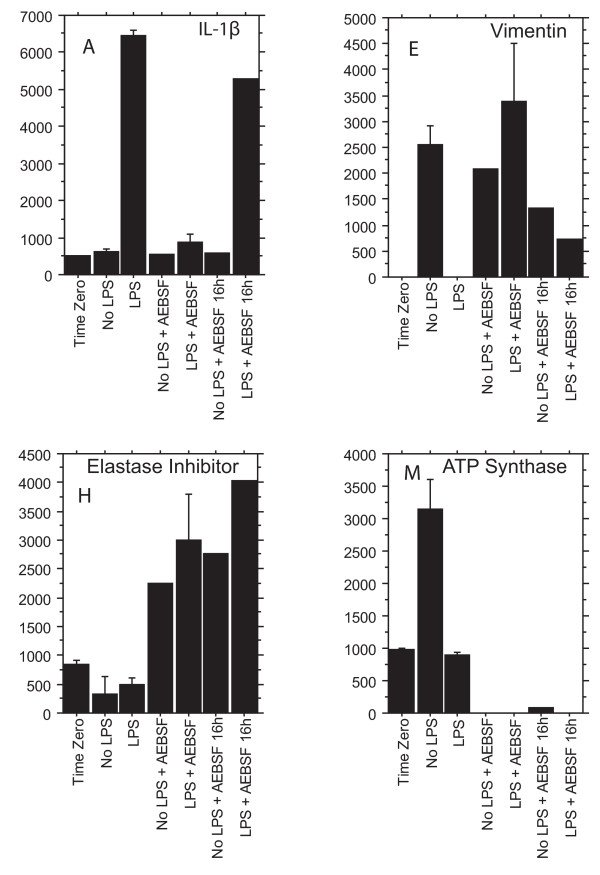
Effects of LPS and AEBSF on expression of IL-1β, elastase inhibitor, vimentin, and ATP synthase. Protein levels from 2D gels from monocytes cultured for 16 h ± LPS ± AEBSF are shown for four spots on the gels. The Y-axis represents integrated normalized spot intensity, as calculated by PDQuest. The first bar is Time 0, a control of monocyte cell protein taken at the start of culture. The last two bars show the effect of AEBSF added at the end of the culture at 16 h. Letters designate particular spots on the gel. Results are means ± SE from the last gel run involving the last two donors; results from the first two donors were similar. LPS increased the expression of the particular form of IL-1β precursor found in spot A, but decreased the vimentin spot E and the ATP synthase spot M. AEBSF enhanced expression of elastase inhibitor in spot H. Results from all 30 differing spots are provided in Additional File 5. Representative gels ± LPS ± AEBSF, with spots identified by letter, are shown in Additional Files 1, 2, 3 and 4.